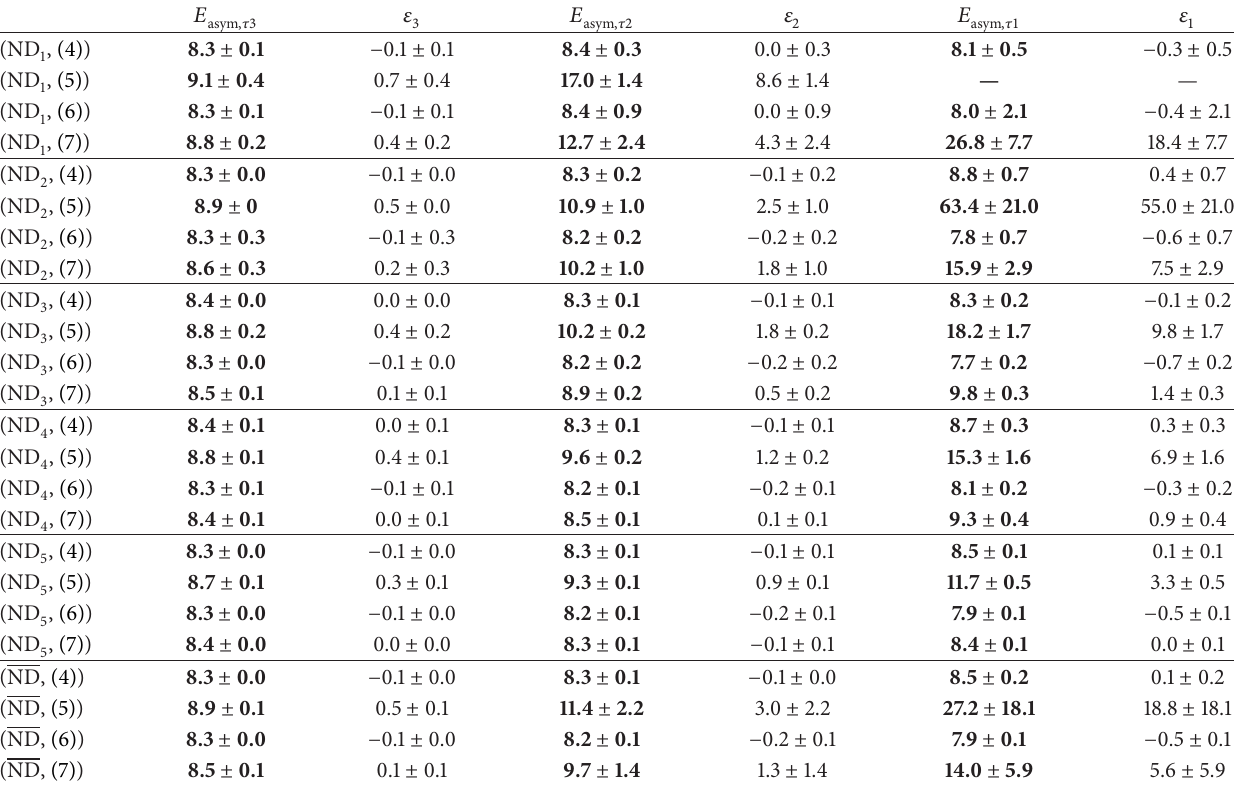
Table 3: Average values over 𝑀 1,...,5 of 𝐸 , calculated from approximations (4)–(7) for all initial conditions ND 1,...,5 and for all asym, 𝜏1,...,3 prediction time lengths 𝜏 1,...,3 (bold columns), average value ND over ND 1,...,5 for all prediction time lengths 𝜏 1,...,3 and difference 𝜀 1,...,3 of − 𝐸 𝐸 asym, 𝜏1,...,3 asym